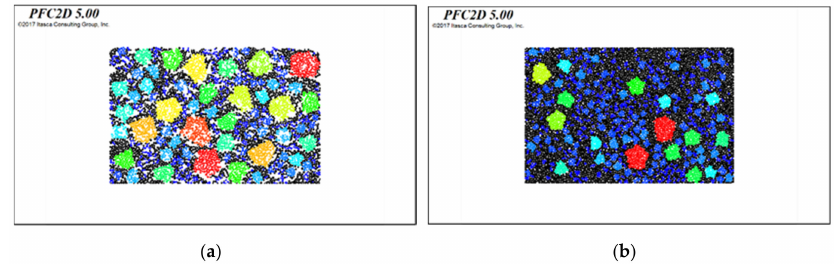
Figure 4. Two-dimensional Particle Flow Code (PFC) model of ( a ) OGFC and ( b )